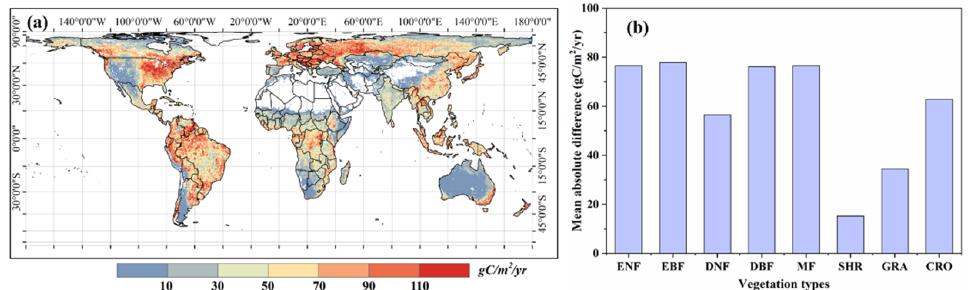
Figure 4. The spatial pattern of ( a ) the mean absolute NEP difference and ( b ) counted by different vegetation types during the study period.